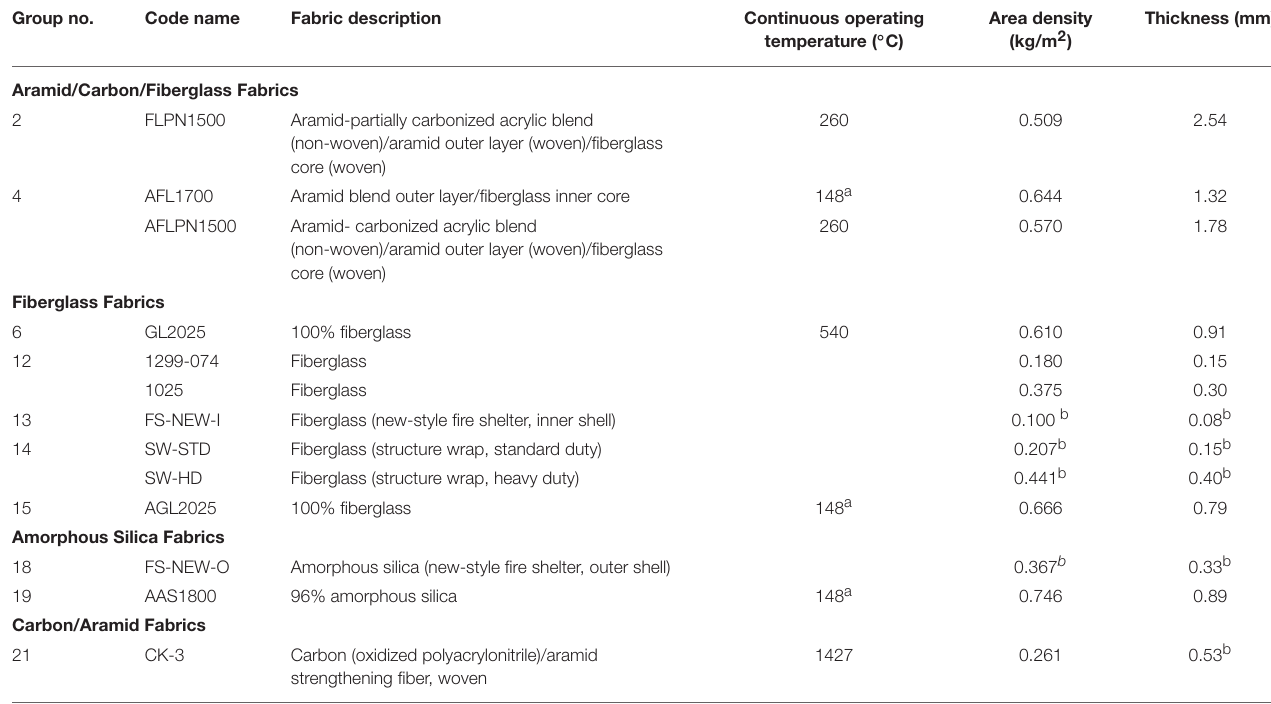
TABLE 1 | Fabrics evaluated. Group